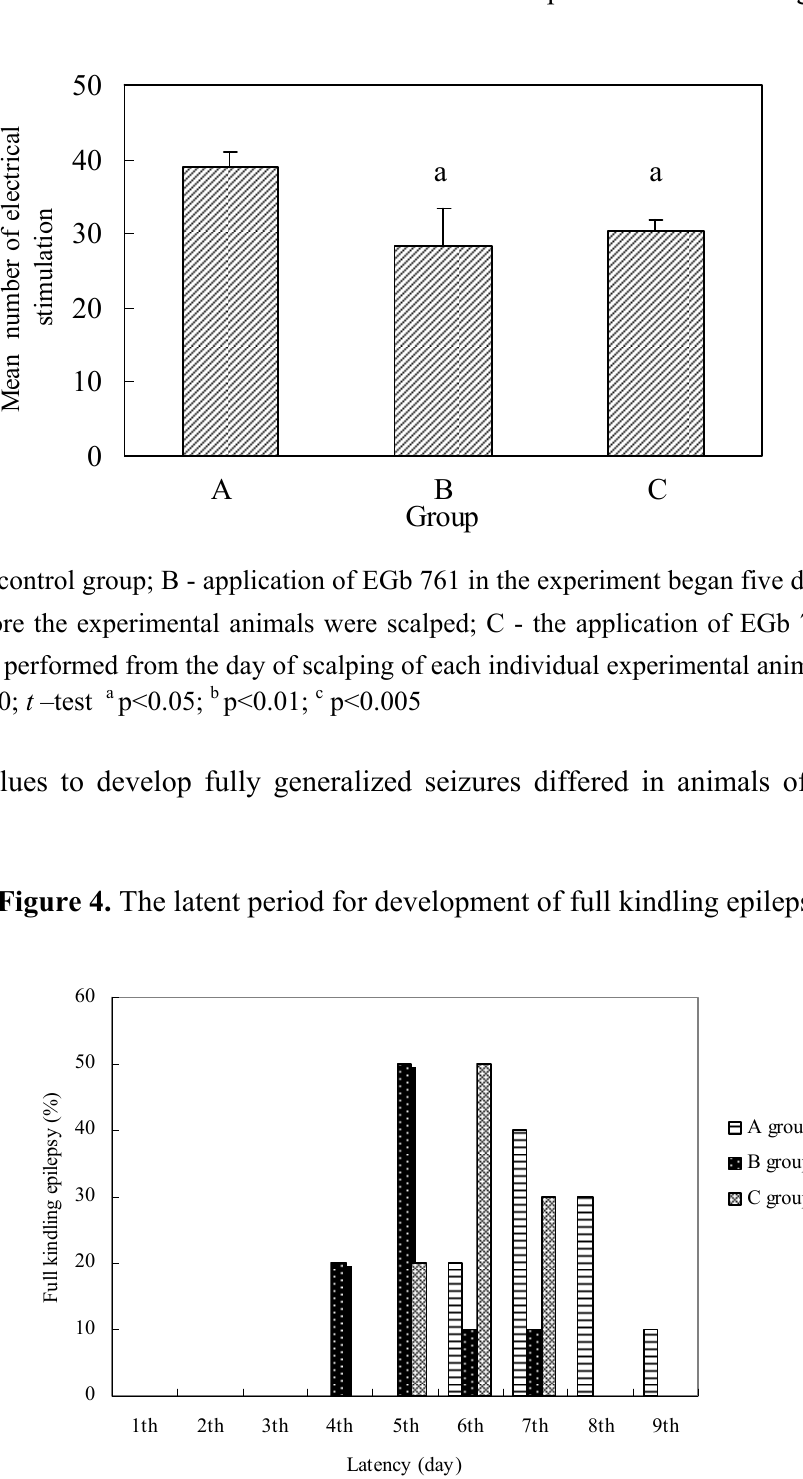
Figure 3. Number of electrical stimulation for development of full kindling epilepsy.